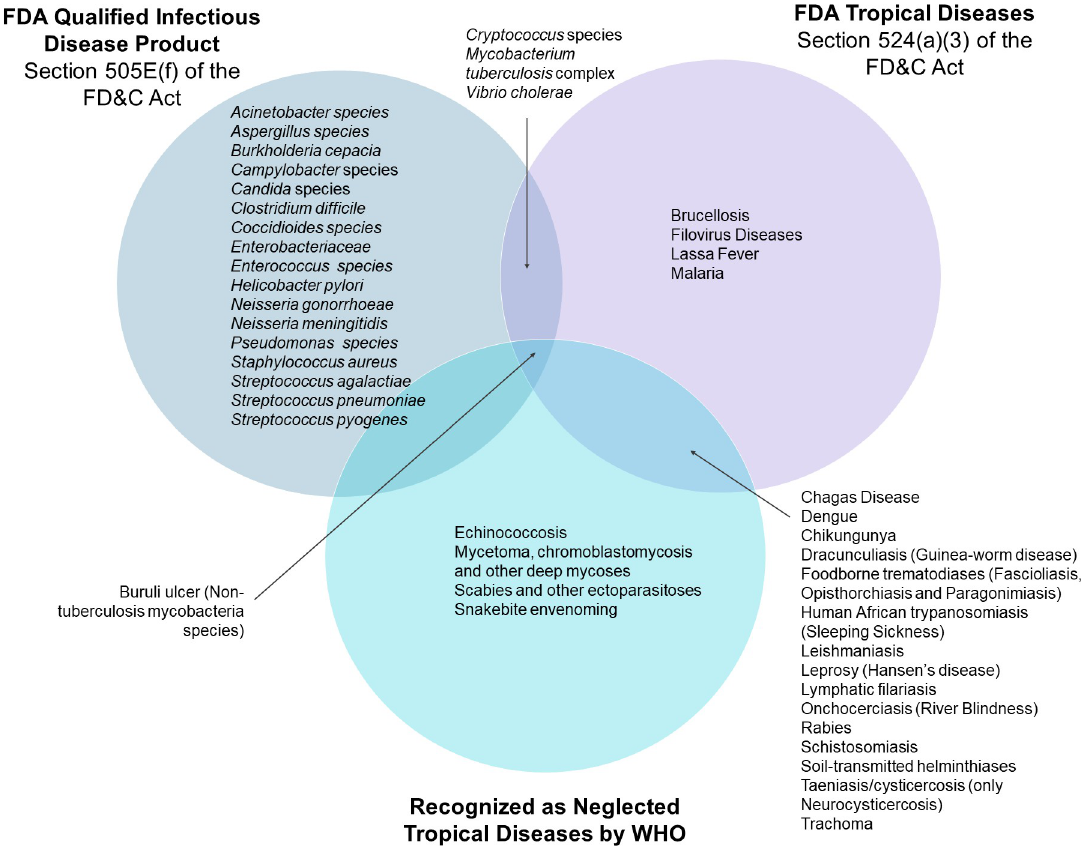
Fig 4. Overlap between diseases considered as QIDPs by FDA, tropical diseases by FDA, and NTDs by WHO. Information for this figure was generated using Section 505E(f) of the FD&C Act, Section 524(a)(3) of the FD&C Act and WHO’s list of NTDs. FDA, Food and Drug Administration; FD&C, Federal Food, Drug, and Cosmetic; NTD, neglected tropical disease; QIDP, qualified infectious disease product; WHO, World Health